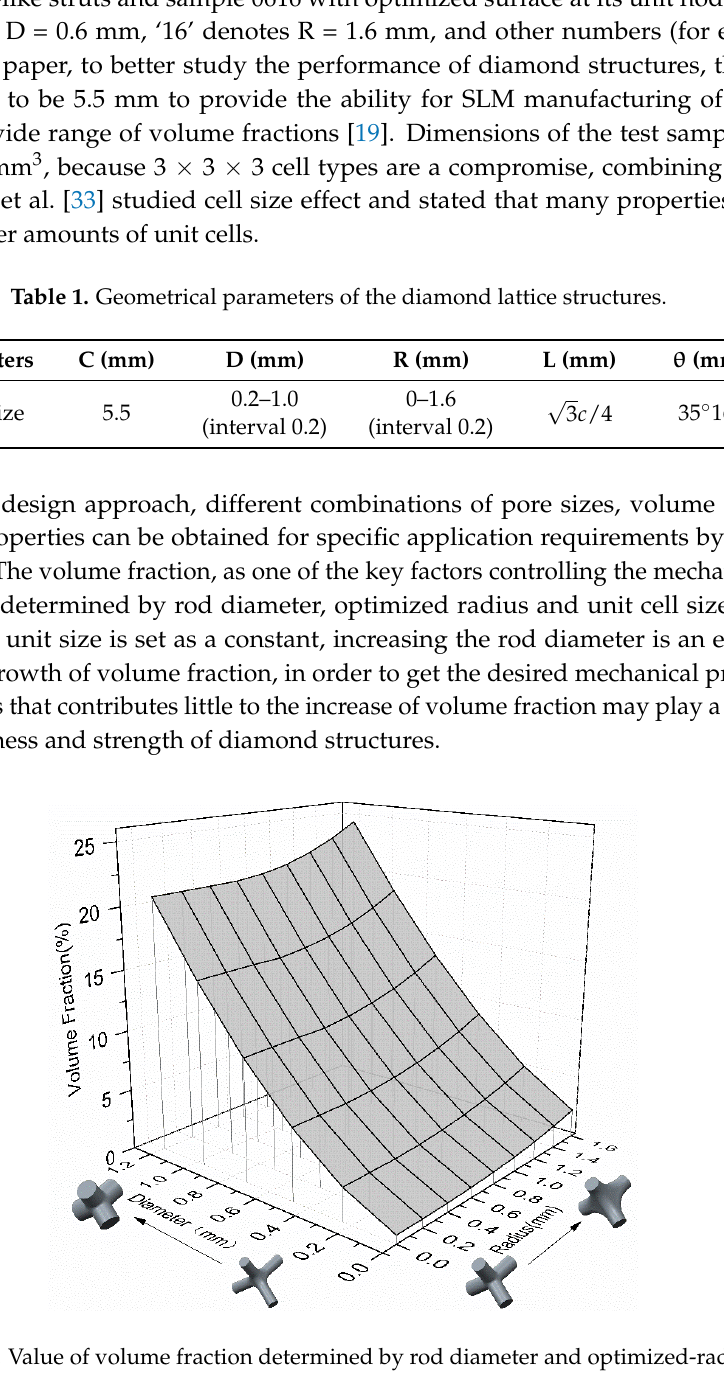
Table 1. Geometrical parameters of the diamond lattice structures.